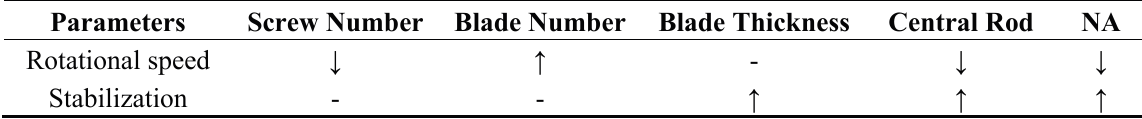
Table 1. Qualitative summary of the influences of screw geometry and the NA. Parameters Screw Number Blade Number Blade Thickness Central Rod NA Rotational speed ↓ ↑ - ↓ ↓ Stabilization -